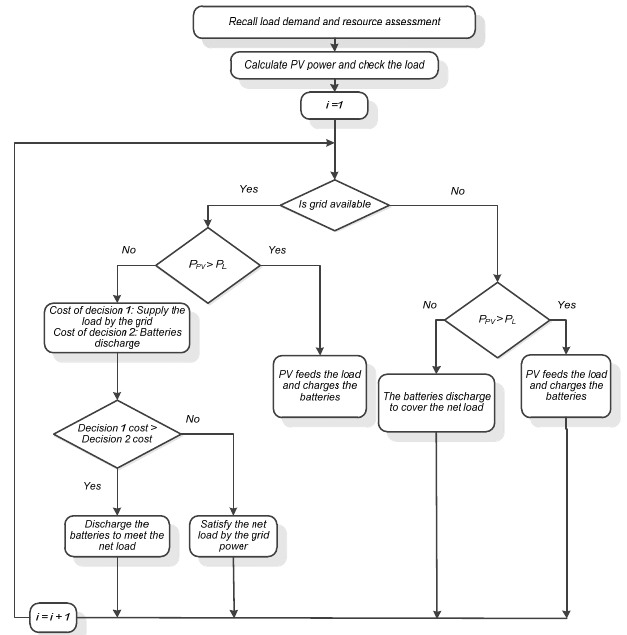
Figure 8. LF strategy for grid-connected PV/battery system.